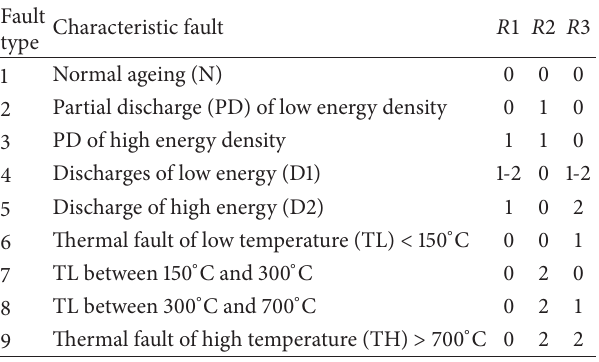
Table 2: Classification of faults by IEC method